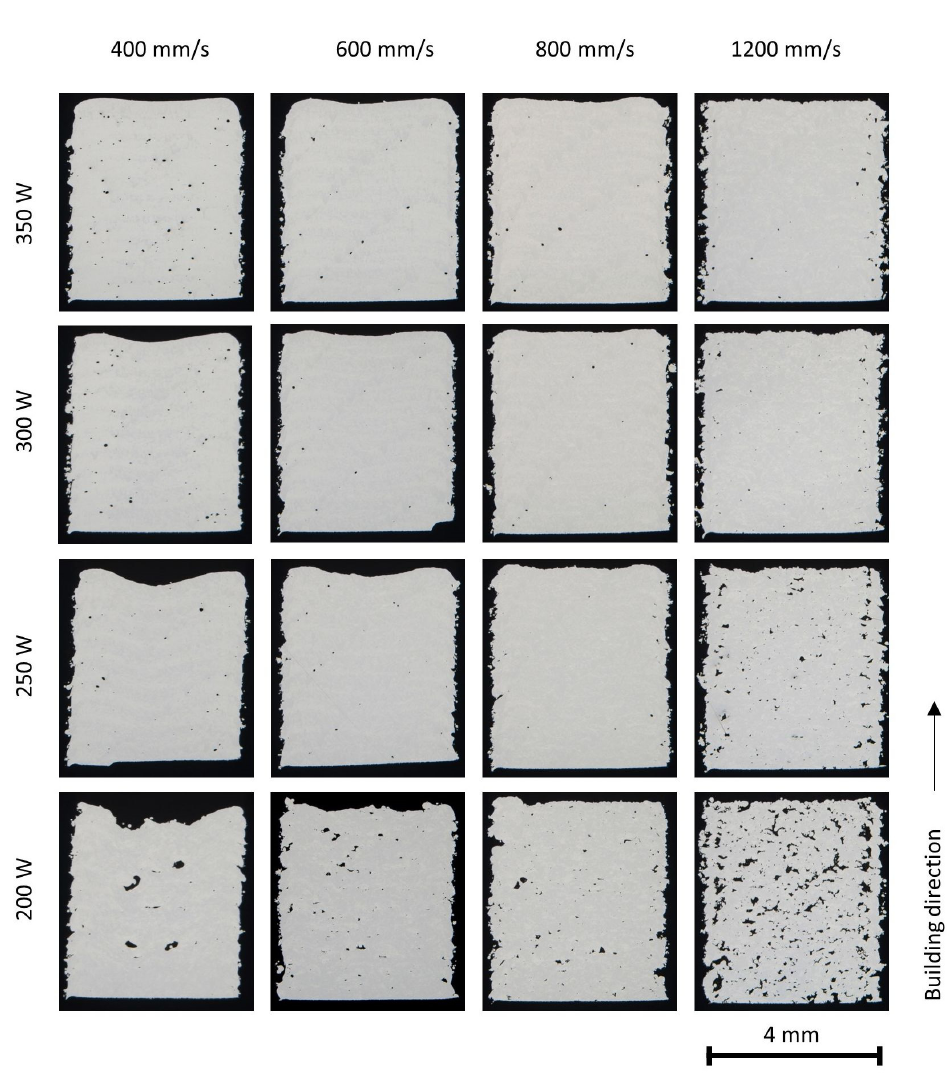
Figure 8. Stereo microscopy of the 50% X2CrNiMo17-12-2 + 50% X2CrNiMoN25-7-4 cubes (4 × 4 × 5 mm 3 ) built with various process parameters.